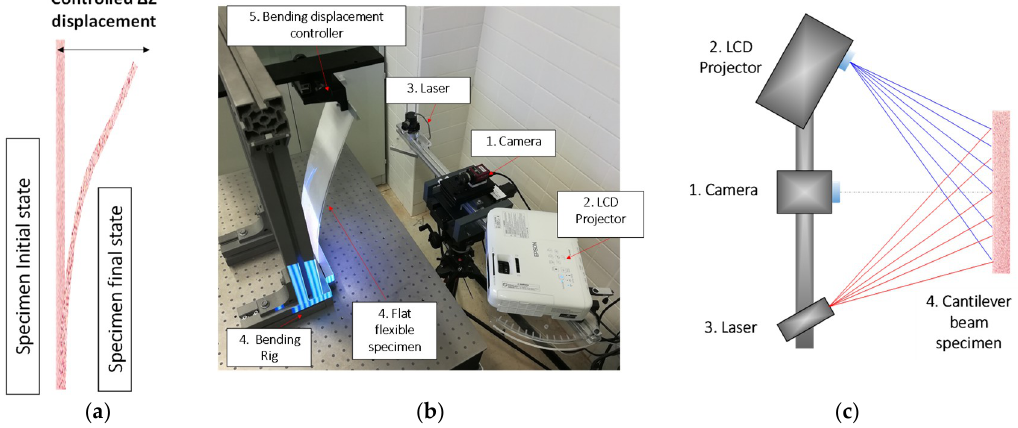
Figure 8 . Set-up employed in bending test. ( a ) Schematic displacement inferred to cantilever beam; ( b ) actual set-up; ( c ) schematic distribution.